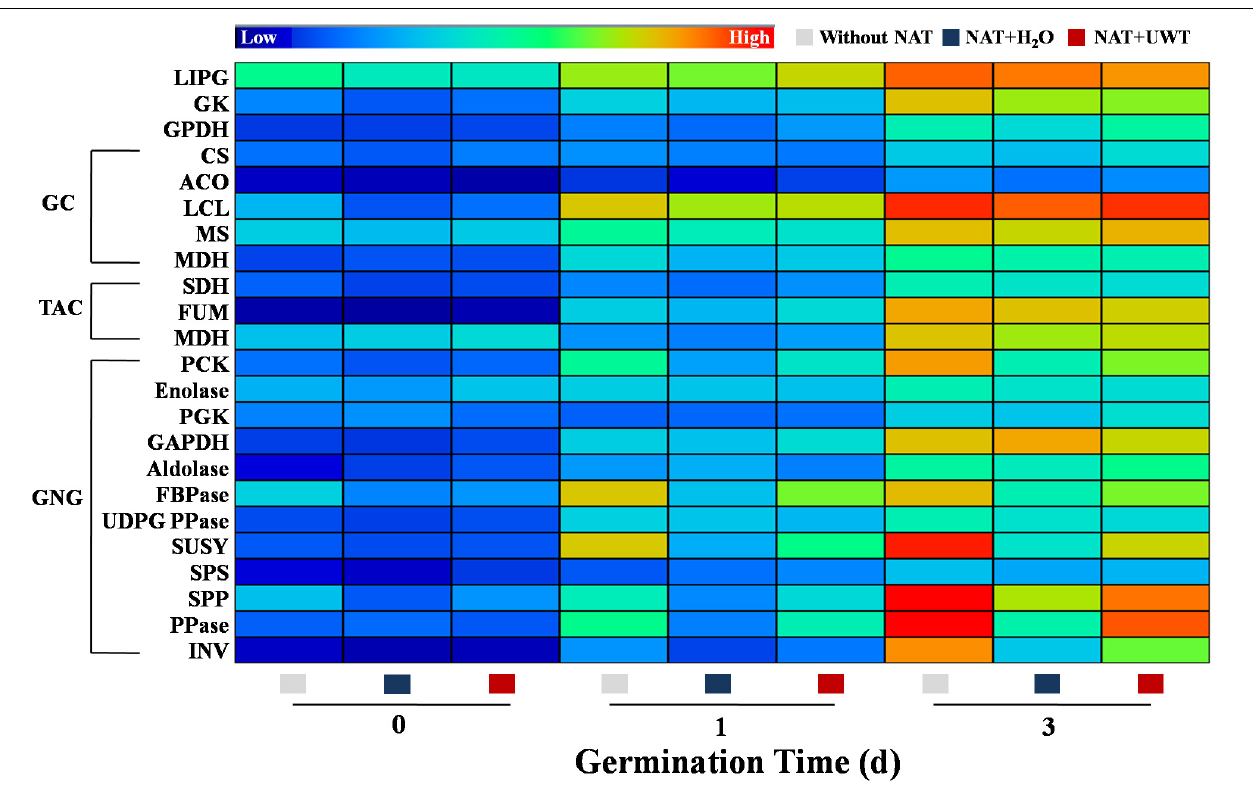
FIGURE 7 | Ultrasonic waves treatment made an effect on the activities of enzymes related to triacylglycerol metabolism of aged soybean seeds during early germination. Without NAT, fresh seeds without naturally aging treatment (NAT); NAT + H 2 O, Seeds stored for 12 months with H 2 O; NAT + UWT, NAT seeds with ultrasonic waves treatment (UWT). LIPG, Lipase; GK, Glycerol kinase; GPDH, α -glycerol phosphate oxidoreductase; CS, citrate synthase; ACO, aconitase; ICL, isocitrate lyase; MS, malate synthase; MDH, malate dehydrogenase; SHD, succinate dehydrogenase; FUM, fumarase; PCK, phosphoenolpyruvate carboxykinase; PGK, phosphoglycerate kinase; GAPDH, glyceraldehyde-3-phosphate dehydrogenase; FBPase, fructose-1,6-bisphosphatase; UDPG PPase, UDPG1c pyrophosphorylase; SUSY, sucrose synthase; SPS, sucrose-6-P synthase; SPP, sucrose phosphatase; PPase, pyrophosphatase; INV, invertase. The heat map was created by the Illustrator software, and the enzyme activities levels from lowest to highest were represented by different colors from blue to red in the entire